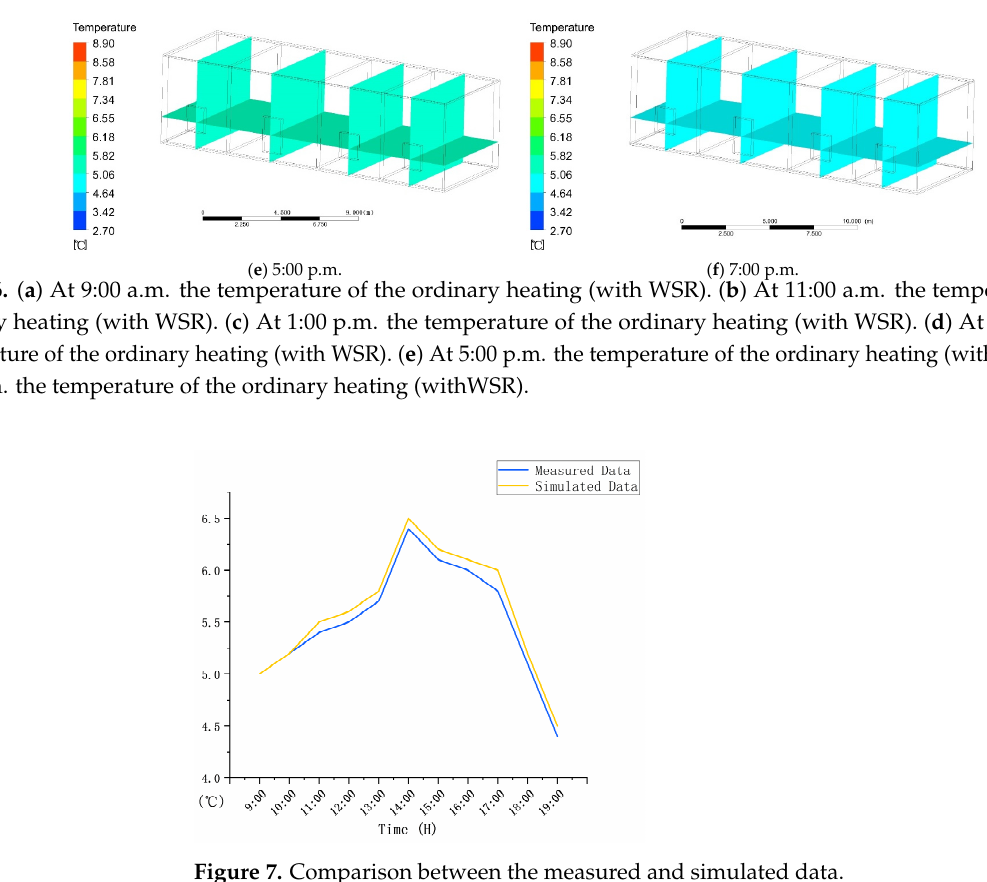
Int. J. Environ. Res. Public Health 2021 , 18 , x FOR PEER REVIEW Figure 7. Comparison between the measured and simulated data. Figure 7. Comparison between the measured and simulated data.